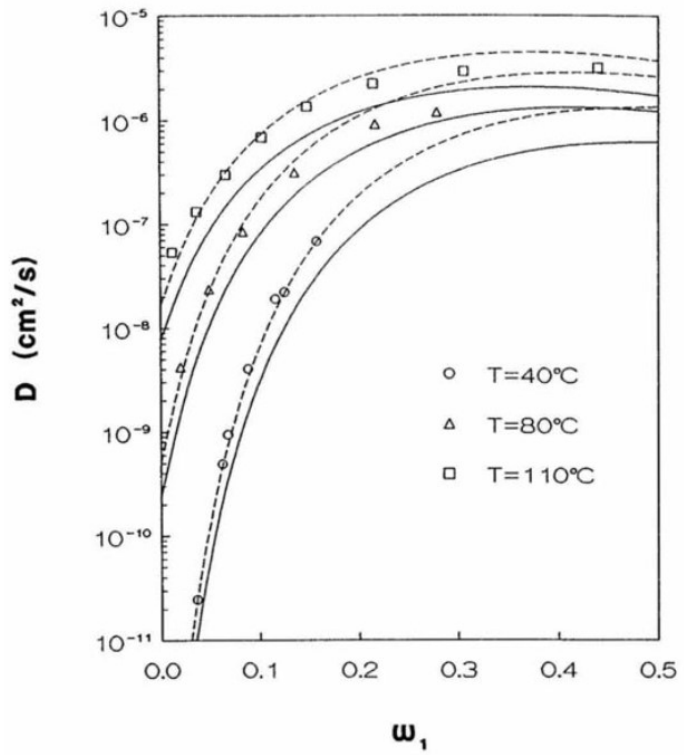
Figure 10. Comparison of mutual diffusion coefficients predicted from free-volume theory with experimental data for toluene/poly(vinyl acetate) systems at 40, 80, and 110 °C. Solid lines are based on the purely predictive techniques of Zielinski and Duda [206]. Dashed lines use data at 40 °C to determine D 0 . Reprinted with permission from Ref. [23]. Copyright 1996, CRC Press.